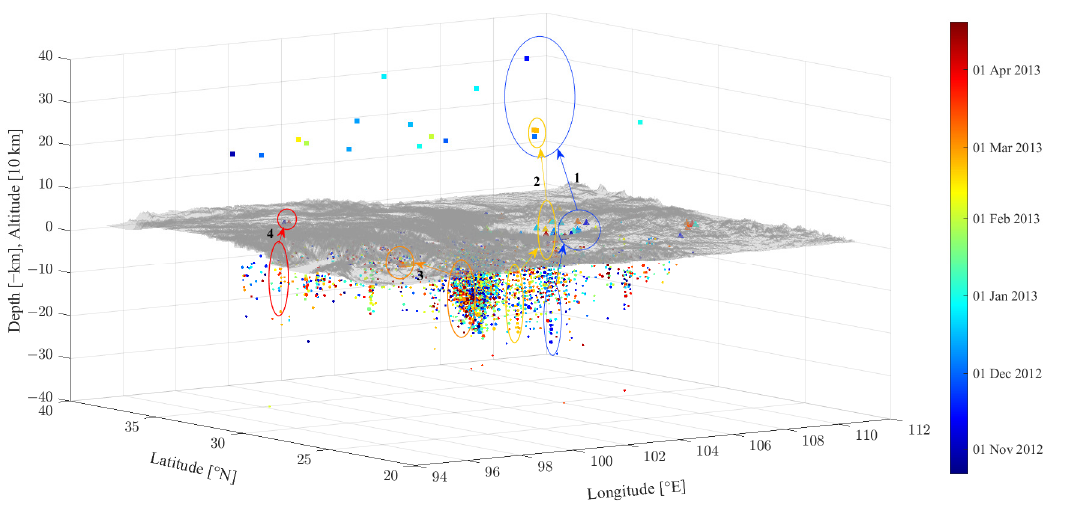
Figure 24. Four-dimensional map of the lithosphere, atmosphere, and ionosphere anomalies or events. The triangle represents anomalies in the atmosphere, the square represents anomalies in the ionosphere and geomagnetic ground data, and the dots represent anomalies in the lithosphere. The number from 1 to 4 with corresponding ellipses represents possible geophysical interactions in time ‐ order of occurrence.